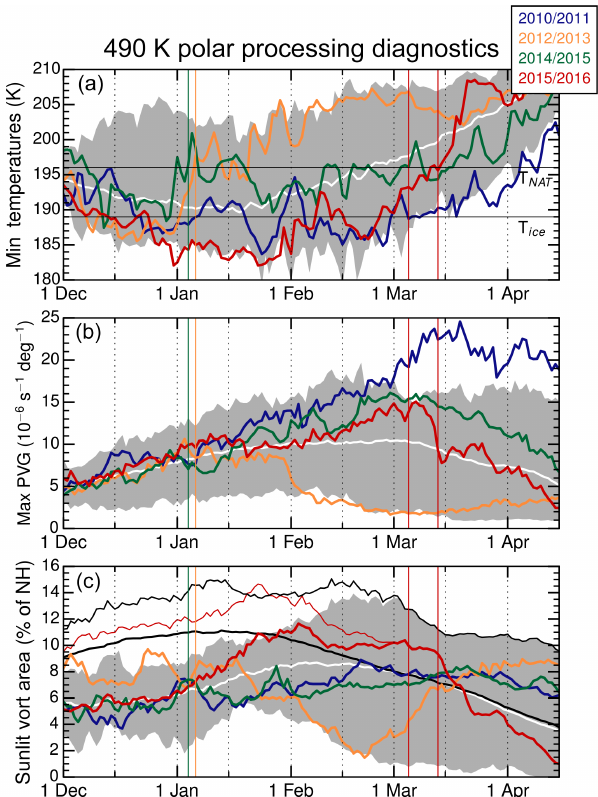
Figure 1. Time series of (a) minimum temperatures, (b) maximum gradients of scaled potential vorticity as a function of EqL (Max PVG), and (c) sunlit area of the polar vortex from MERRA-2 in the 2010/11 (blue), 2012/13 (orange), 2014/15 (green), and 2015/16 (red) Arctic winters compared with the mean (white) and range (grey shading) of other years on record beginning with 1979/80. Thin vertical lines indicate significant SSW dates: 6 January 2013 and 5 March 2016 (first red line) are the dates when major SSW criteria were met in those winters, 4 January is the date when the 2015 minor SSW briefly split the vortex, and 13 March (second red line) is the approximate date of the 2016 vortex split. In (a) , the thin black horizontal lines indicate the approximate NAT and ice PSC thresholds. In (c) , in addition to the thick colored lines indicating sunlit vortex area, the thin red line indicates the total vortex area in 2015/16, with the thick/thin black lines showing the daily climato- logical average/maxima of vortex area; at times when the thick and thin red lines coincide, the vortex is fully in sunlight. All of these diagnostics are shown on the 490K isentropic